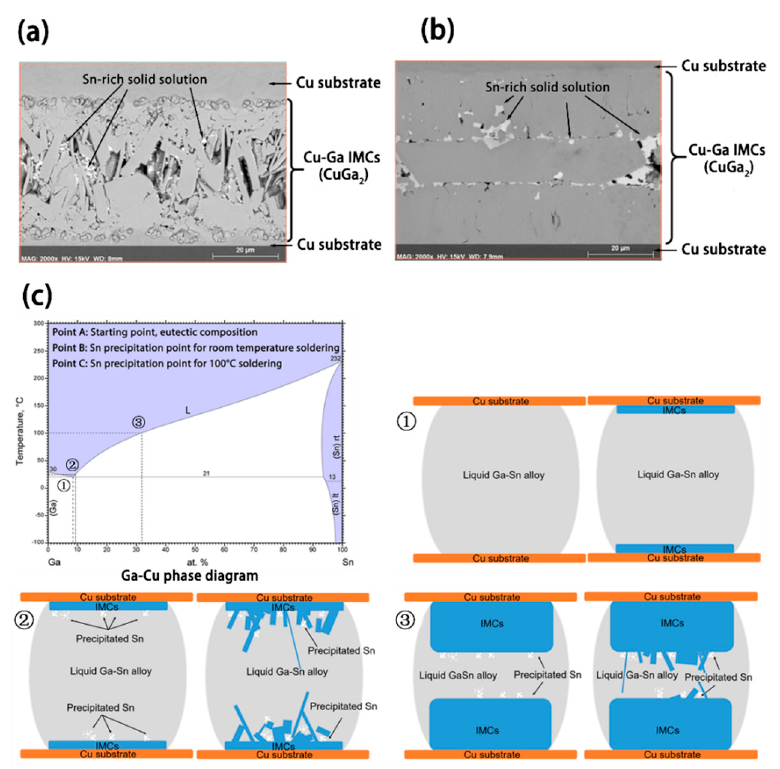
Figure 10. Microstructure evolution of joints formed between EGaSn and Au-coated Cu substrates [64]. ( a ) SEM image of a Cu/Au/EGaSn/Au/Cu substrate sandwich couple formed at room temperature; ( b ) SEM image of a Cu/Au/EGaSn/Au/Cu substrate sandwich couple formed at 100 ◦ C; ( c ) schematic diagram of sandwich joint interface formation showing the relative difference in the intermetallic compound (IMC) thickness at the time of Sn precipitation at room temperature ( c - 2 (cid:13) ) and at 100 ◦ C ( c - 3 (cid:13) ). At the starting point ( 1 (cid:13) ), liquid GaSn alloy contained 91.6 at% Ga and 8.4 at% Sn. The continuous planar IMC layer grows, which causes the Ga concentration in the liquid to drop. For the room temperature joint, the Ga concentration quickly reaches the limit where solid Sn (Ga) starts to form ( 2 (cid:13) ). At this point, the independent growth of Sn (Ga) disrupts the growth of planar IMCs. For the sandwich couple at 100 ◦ C, solid Sn (Ga) will not form until the concentration of Ga in the liquid GaSn alloy decreases to 68.2 at% ( 3 (cid:13) ). Compared with the reactions at room temperature, the solid Sn (Ga) precipitation occurs much later at 100 ◦